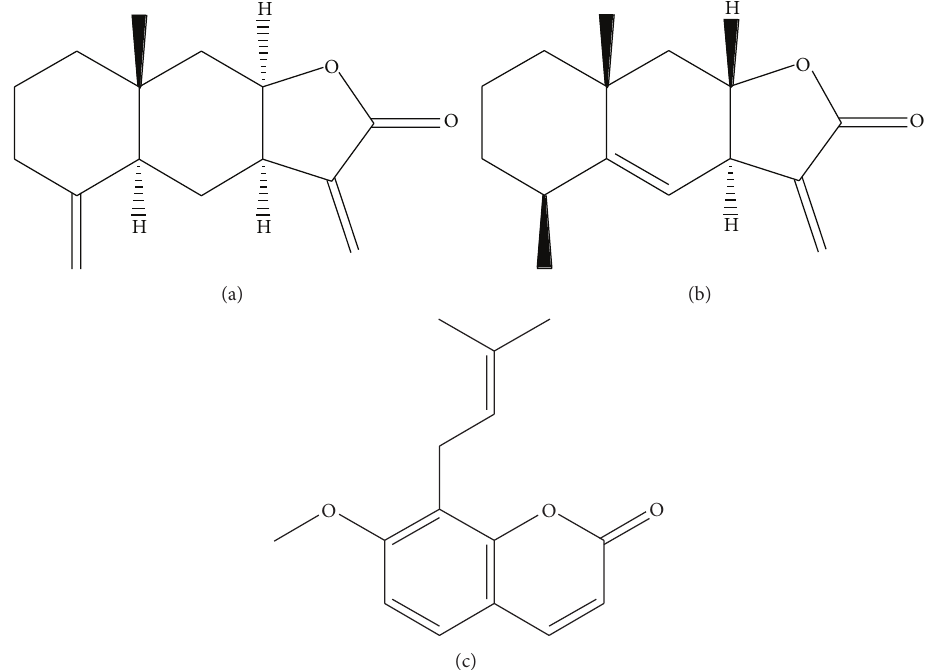
Figure 1: Structures of isoalantolactone (a), alantolactone (b), and osthole ((c),